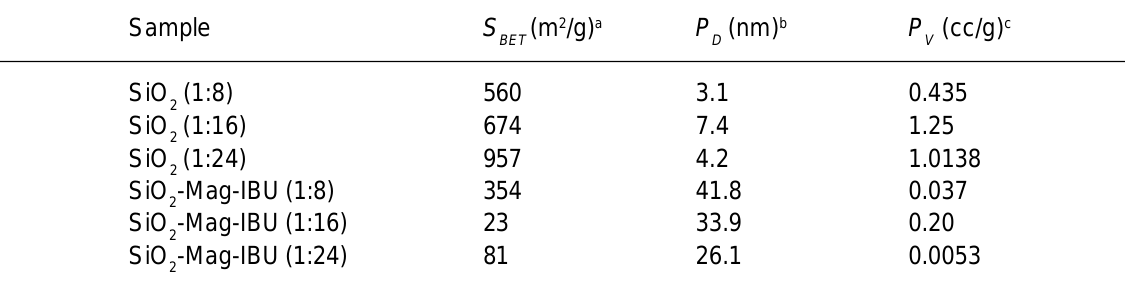
Table 4. Surface properties of silica and silica-Mag-IBU samples.